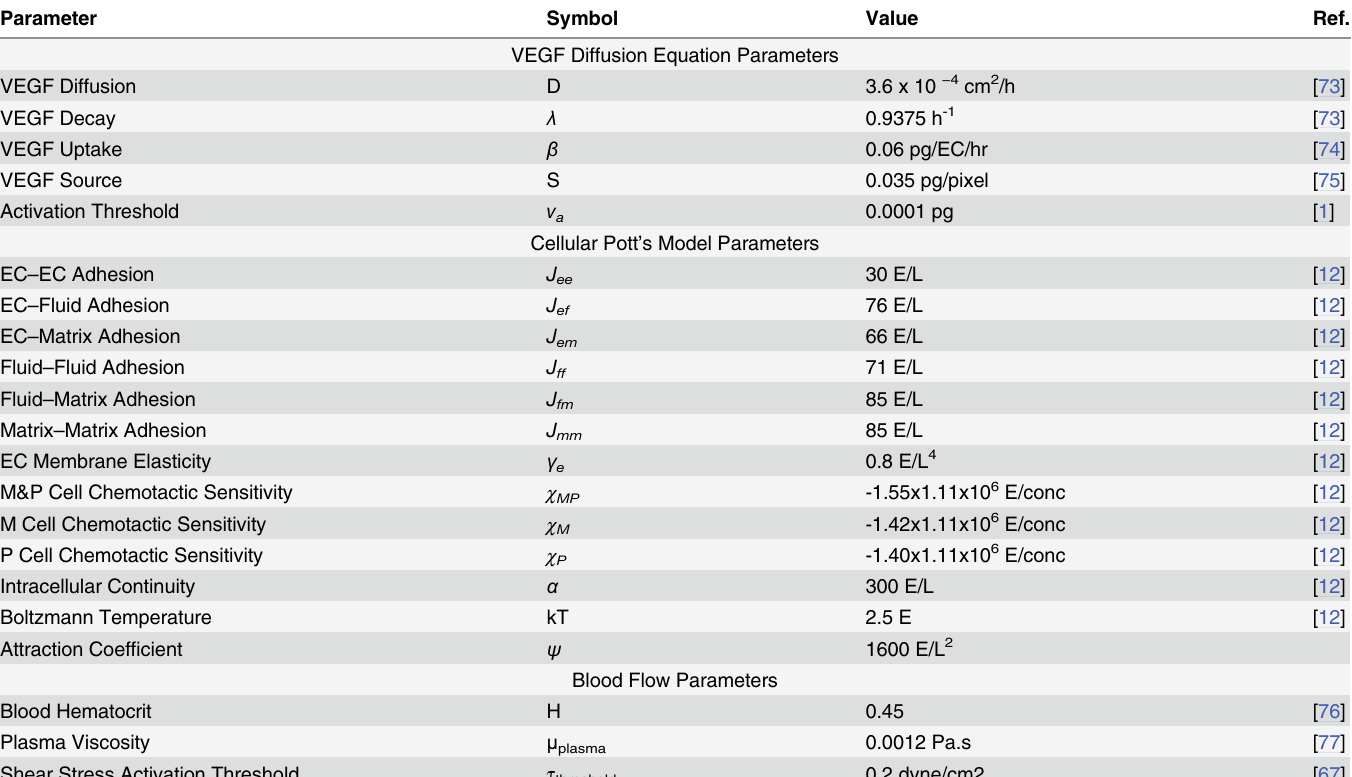
Table 2. Parameters used in the model and corresponding